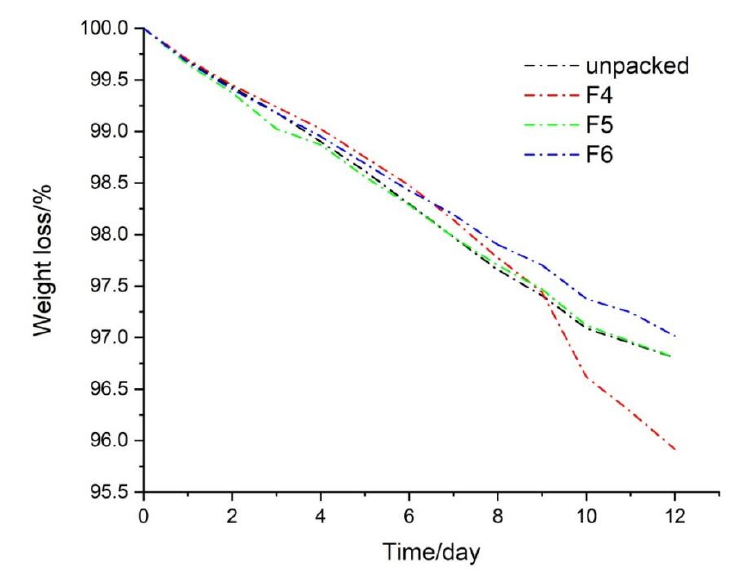
Figure 11. Weight loss of cherry tomatoes in the package application.